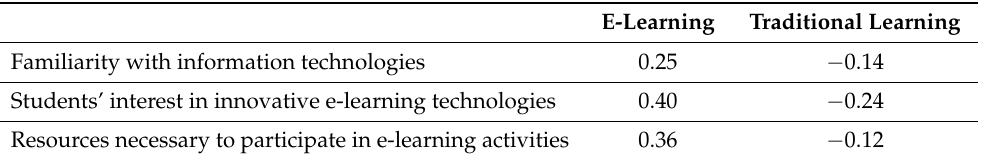
Table 2. Spearman’s correlation between the ease of acquiring content and assessment of familiarity, interest, and the possibility of using e-learning